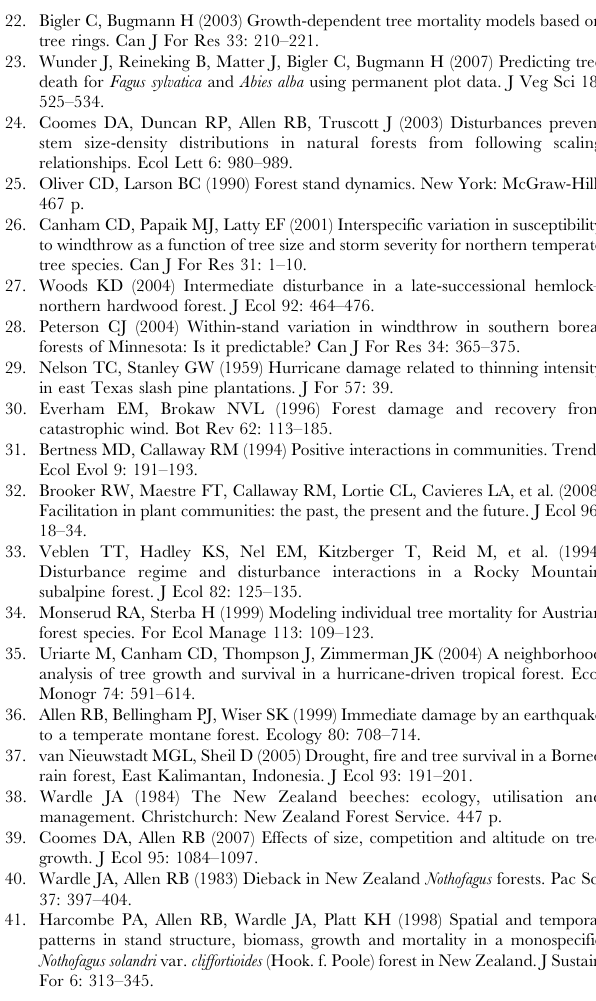
Figure S1 Goodness of fit of the full individual-based models. Goodness of fit graphs (see Table 1) for small (D , 20 cm) and large (D $ 20 cm) trees, for each of three census periods: 1974–1983, 1983–1993 and 1993–2004. Points represent the observed proportion of trees that died as a function of predicted mortality probability, and numbers above points indicate the number of observations in each probability class. Diagonal lines represent a 1:1 relationship between observed and predicted mortality. Table S1 Parameter estimates for full individual-based models. Mean ( 6 SD) lower 95% and upper 95% of posterior distribution